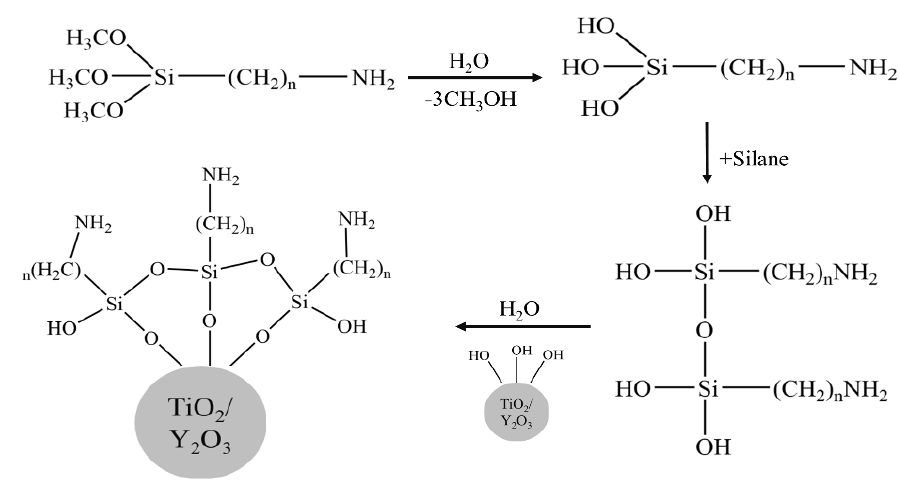
Figure 2. Reaction scheme for the surface functionalization of Y 2 O 3 /TiO 2 by APTMS.